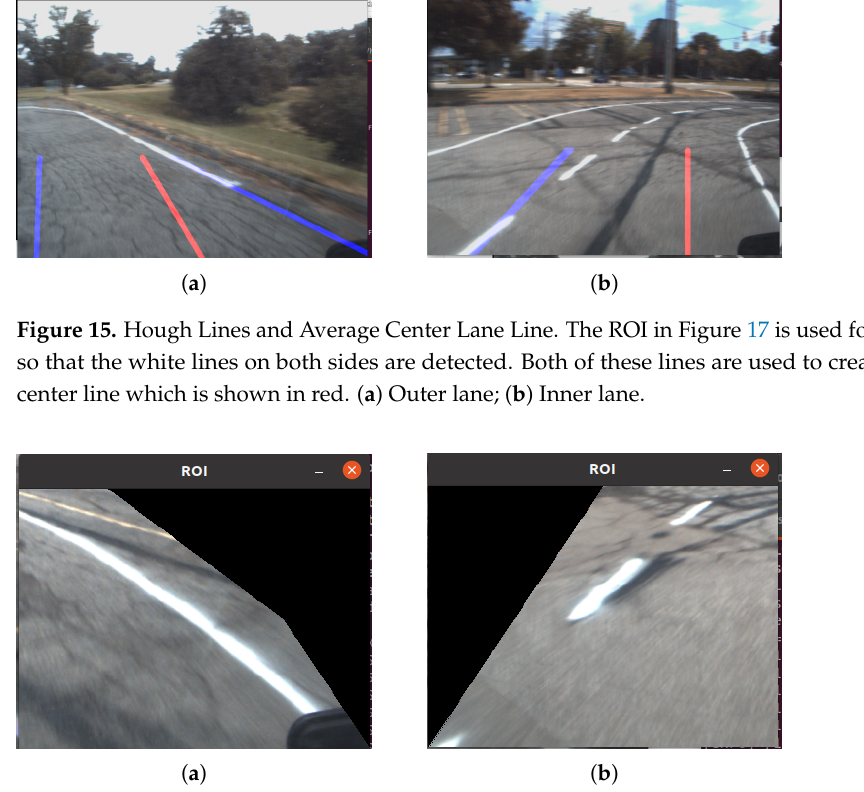
Figure 16. The ROI used for Algorithm II when using the offset method of lane centering. Different ROIs are used for inner and outer lane: ( a ) Outer lane; ( b ) Inner